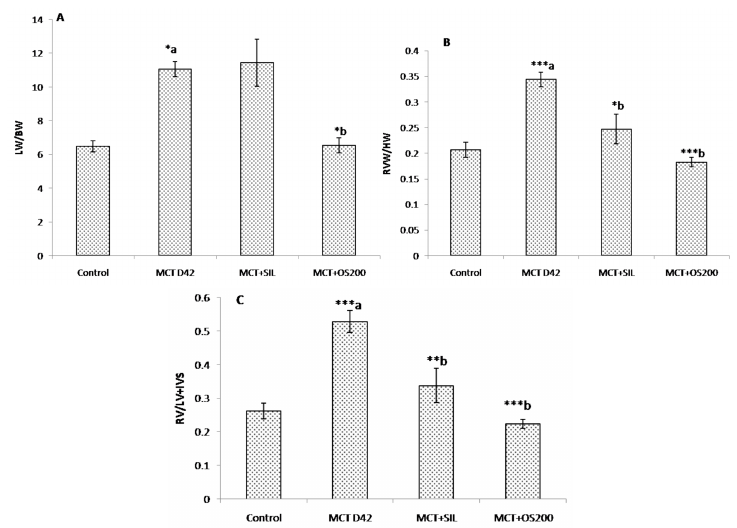
Figure 1. Effect of O. sanctum (OS) on ( A ) LW/HW; ( B ) RV/HW; ( C ) Fulton’s index [RV/(LV + IVS)] in MCT-induced PH. Values are expressed as mean ± SEM ( n = 6). * p < 0.05, ** p < 0.01, *** p < 0.001; a—as compared to control, b—as compared to MCT where; HW: Heart weight, LW: Lung weight, RV: Right ventricular weight, LV: Left ventricular weight, IVS: Interventricular septum weight.